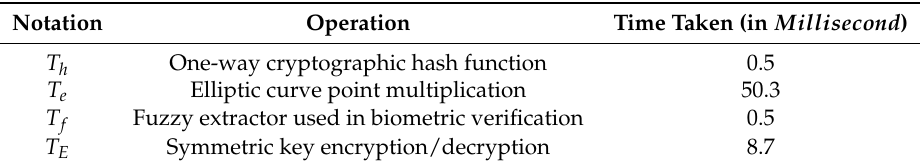
Table 25. Execution time on computer system for cryptographic operation.